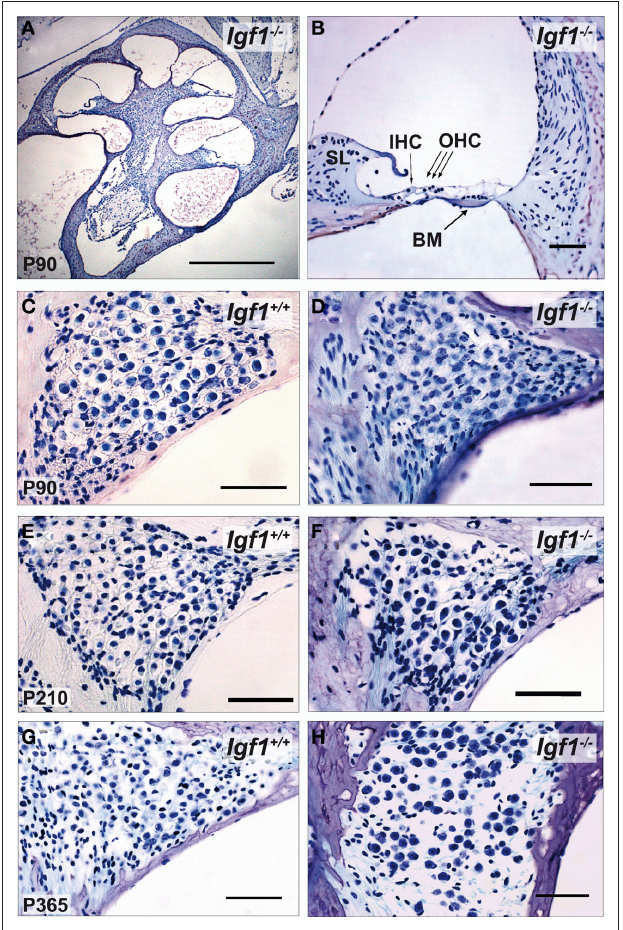
Figure 5 | Comparative study of cochlear morphology with aging in Igf1 + / + wild type and Igf1 − / − null mice. (A,B) Cochlear cross-section and close up of the cochlear basal turn in a representative 3-month-old null mice. The disposition of the cells in the organ of Corti is apparently normal. IHC: inner hair cell; OHC: outer hair cells; BM: basilar membrane. (C–H) Comparison in both genotypes of the spiral ganglion morphology and of the neuronal density in mice at the ages studied. The neuronal density decreased in the aged spiral ganglion, such that at the older ages studied the cochlear ganglia was morphologically similar in both genotypes. Some specimens displayed heavy hair cell loss at this age, which was correlated with the increase in hearing thresholds (data not shown). Scale bar 50 μm [0.5 mm in (A) ].